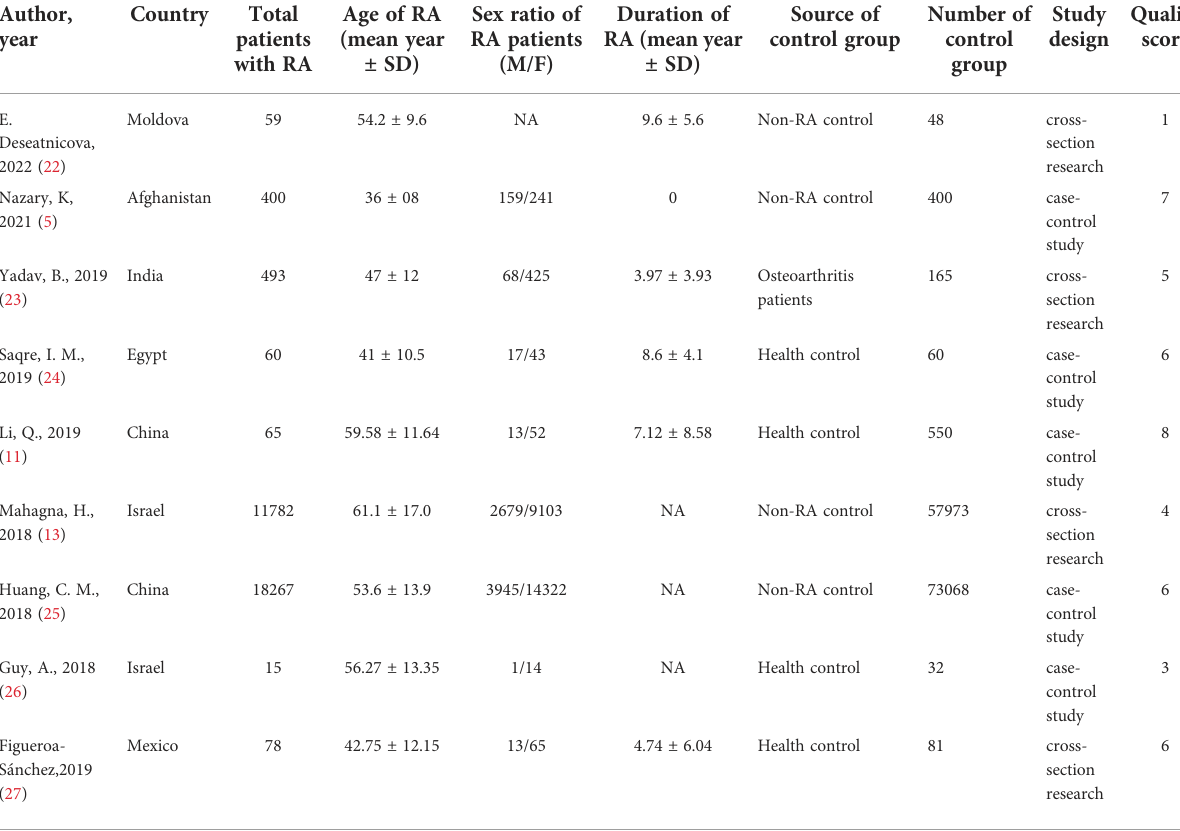
TABLE 1 Characteristic of basic